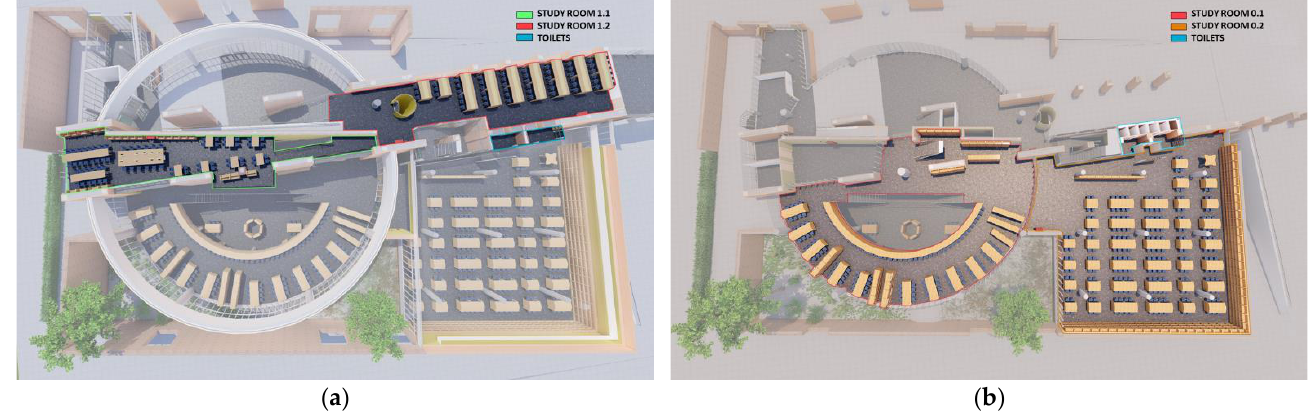
Figure 5. Views rendered with Lumion of the first floor ( a ) and ground floor ( b ) of the General Library of the UMA, available by clicking the option “show images uploaded to A360”.